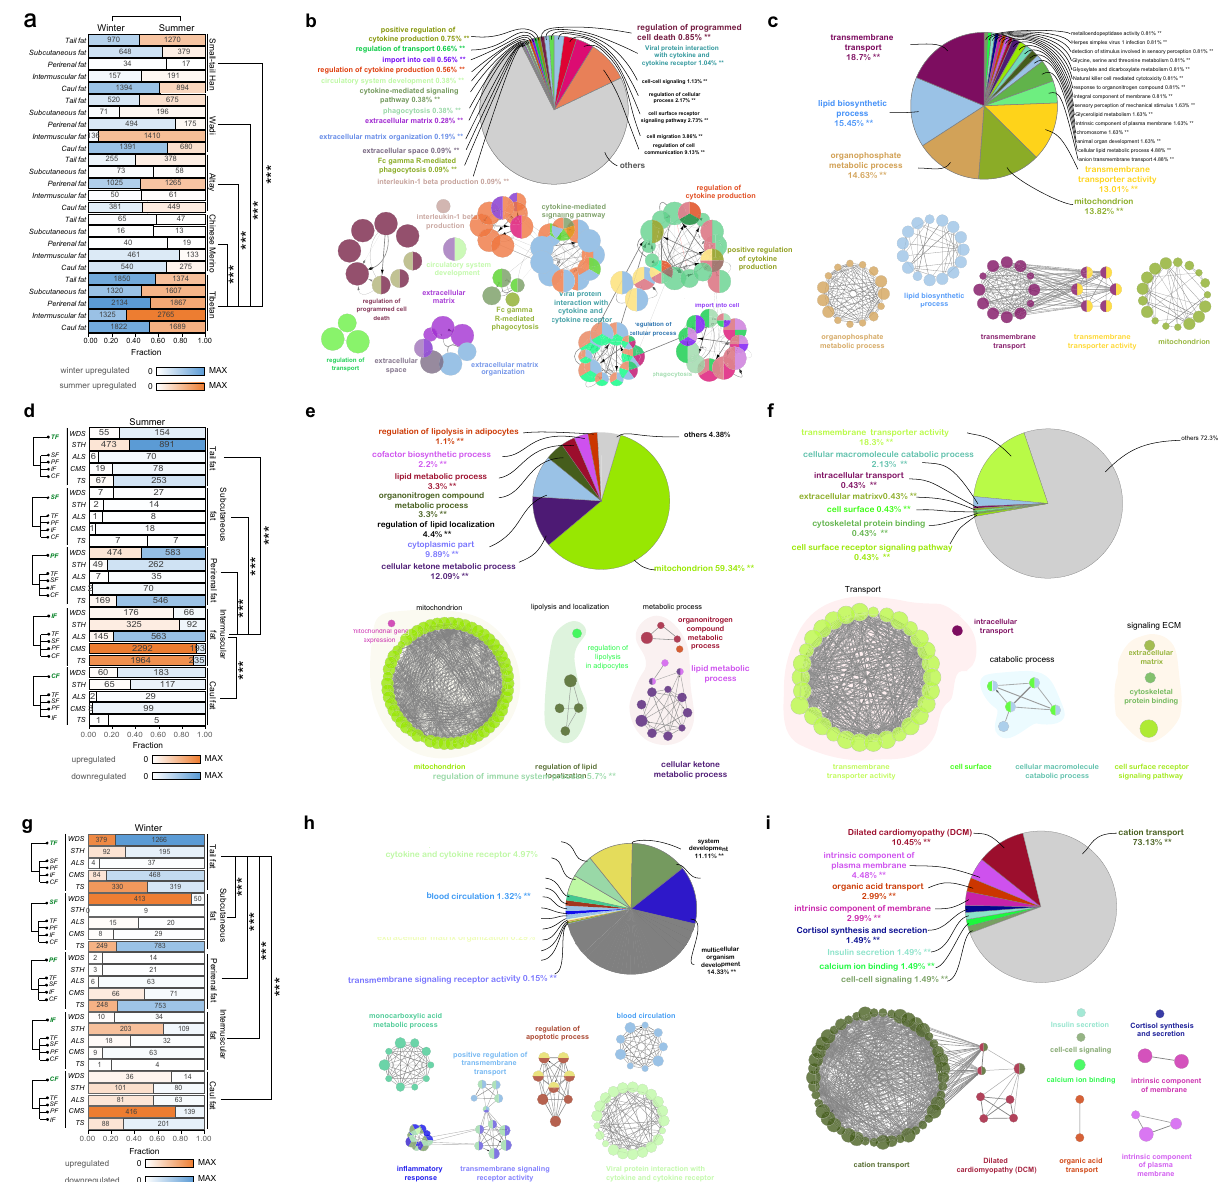
Fig. 2 Gene expression patterns and functions affected by the changing seasons and speci fi c tissues. a Bar chart of the numbers of DEGs found to be upregulated or downregulated in each type of adipose tissue from fi ve breeds between summer and winter samples. b Pie charts of GO terms and KEGG pathways of total upregulated genes identi fi ed in fi ve adipose tissues from Tibetan sheep in winter. c Pie charts of GO terms and KEGG pathways of total upregulated genes identi fi ed in fi ve adipose tissues from Tibetan sheep in summer. d Bar chart of the numbers of upregulated or downregulated genes in each type of adipose tissue from fi ve breeds compared to the other four tissue samples in summer. e Pie charts of GO terms and KEGG pathways of total downregulated genes identi fi ed in intermuscular fat (IMF) from fi ve breeds in summer. f Pie charts of GO terms and KEGG pathways of total upregulated genes identi fi ed in intermuscular fat (IMF) from fi ve breeds in summer. g Bar chart of the numbers of upregulated or downregulated genes in each type of adipose tissue from fi ve breeds compared to the other four tissue samples in winter. h Pie charts of GO terms and KEGG pathways of total downregulated genes identi fi ed in tail fat (TAF) in winter. i Pie charts of GO terms and KEGG pathways of total upregulated genes identi fi ed in tail fat (TAF) in winter. *** P value < 0.001; ** P value < 0.01. These plots are based on results in Supplementary Data 3 – 5, 10 – ≥ 1) identi fi ed between summer and winter ranged from 3 (for The signi fi cantly upregulated lipid metabolites in winter were subcutaneous fat of Altay sheep) and 238 (for intermuscular fat signi fi cantly enriched in metabolic pathways such as the and caul fat of Tibetan sheep) (Fig. 3d and Supplementary regulation of lipolysis in adipocytes, vitamin digestion and Data 21). Although the relative abundance of lipids showed absorption, metabolic pathways, and insulin resistance (Fig. 3f differences among tissues and populations (Fig. 3d), the and Supplementary Data 23). Notably, we observed different signi fi cantly upregulated lipid metabolites in summer were functions of the differential metabolites in Altay sheep (Fig. 3e, f). related to several metabolic pathways such as thermogenesis, These functions of signi fi cantly upregulated lipids were consistent cholesterol metabolism, fat digestion and absorption, and with those of signi fi cantly upregulated DEGs from transcriptome glycerolipid metabolism (Fig. 3e and Supplementary Data 22). analyses of winter and summer samples.